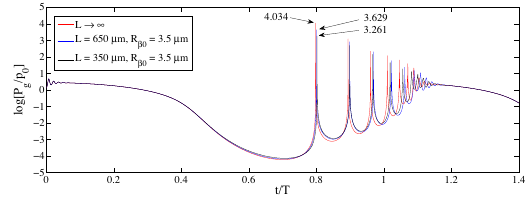
Figure 7. Temporal evolution of P g at different distances between bubble centers ( L ) ( T = 50 l s, R a 0 = 4.5 l m, p 0 = 1.013 (cid:8) 10 5